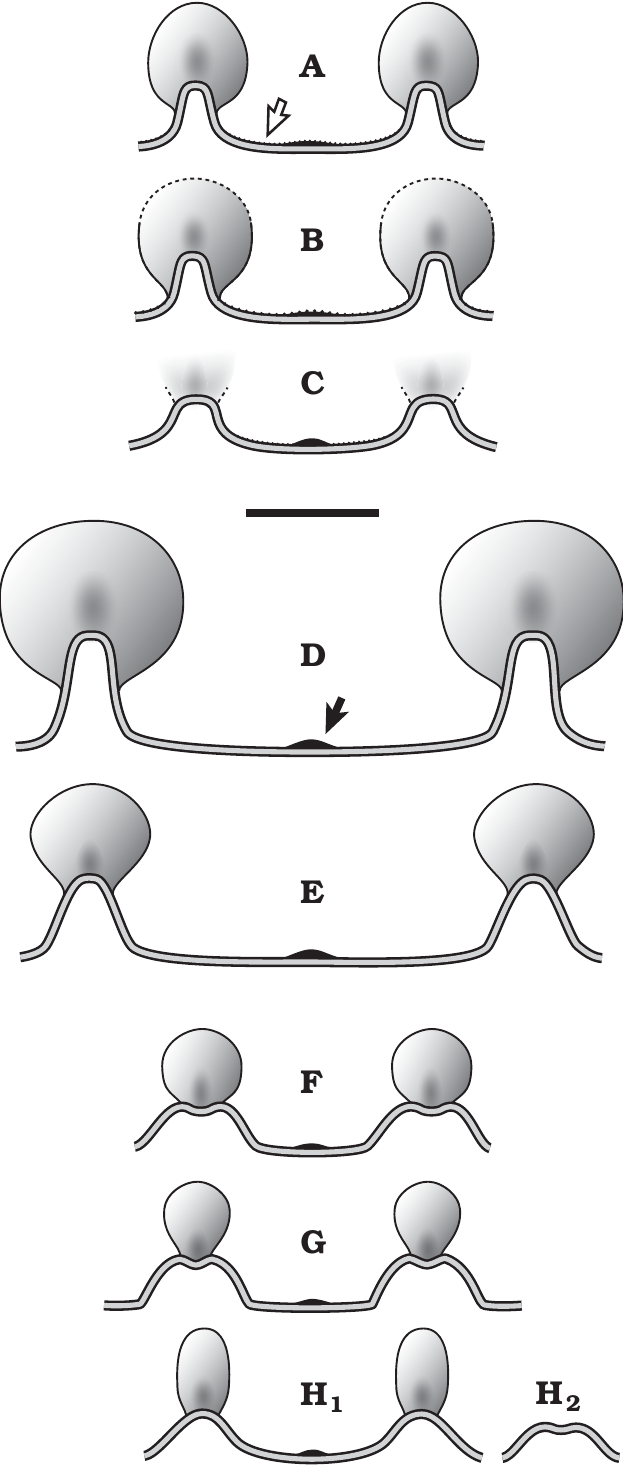
Fig. 16. Comparative rib cross-sections and rib sculpture for species of Procardium . Schematic drawings based on the third/fourth rib anterior to the midline, close to the margin of an adult shell. A . P. magnei sp. nov. B . P. jansseni sp. nov. (upper part of rib sculpure reconstructed). C . P. danu- bianum (rib sculpture undefined). D . P. kunstleri. E . P. aff. kunstleri. F . P. avisa nense. G . P. diluvianum. H . P. indicum. Median rib, showing radial groove on rib top (H 2 ). Note presence of microscopic granulations (white arrow) and secondary riblet in interspace (black arrow). Scale bar 5